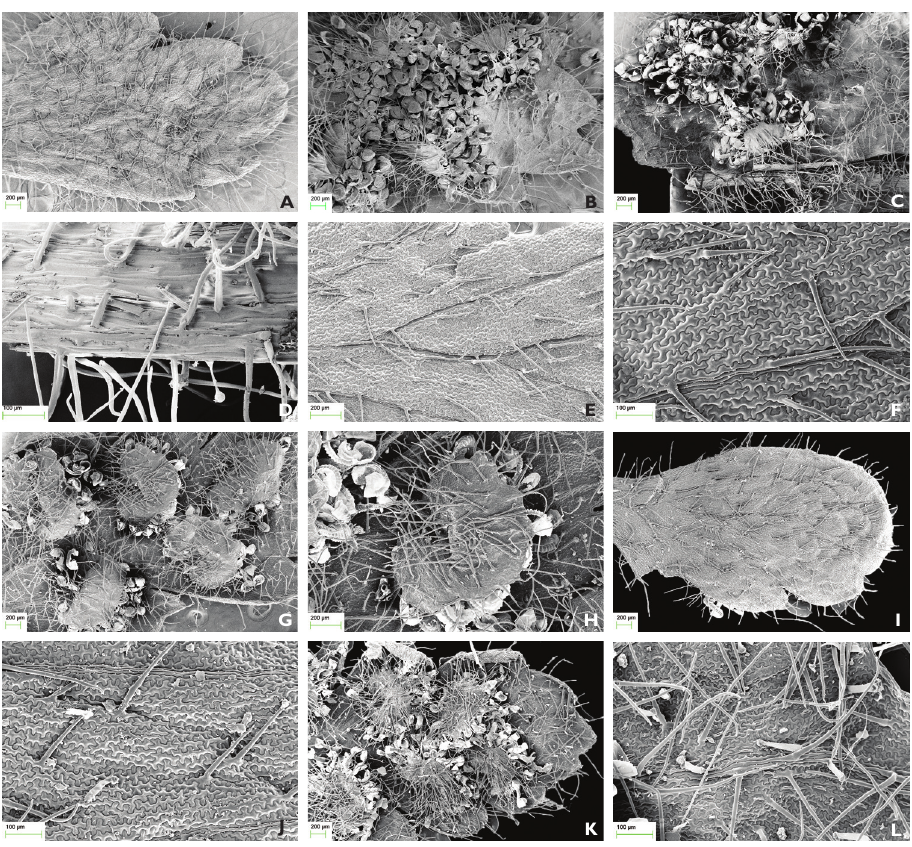
Figure 3. The fronds and rachis of H. confertivillosum , H. crenatum and H. glanduloso-pilosum (SEM). A H. confertivillosum fronds densely covered with long hairs adaxially (30×) B H. confertivillosum fronds and indusia densely covered with long hairs and sparsely rod-shaped glandular hairs abaxially (30×) C H. confertivillosum fronds and costae densely covered with long hairs and sparsely rod-shaped glandular hairs abaxially (30×) D H. confertivillosum costae densely covered with long hairs and sparsely rod-shaped glandular hairs abaxially (160×) E H. crenatum fronds sparsely covered with acicular hairs adaxially (60×) F Close-up view of H. crenatum fronds covered with acicular hairs adaxially (140×) G H. crenatum fronds and indusia densely covered with long hairs abaxially (30×) H Close-up view of H. crenatum indusia covered with long hairs abaxially (60×) I H. glanduloso-pilosum fronds densely covered with acicular hairs and rod-shaped glandular hairs adaxially (30×) J Close-up view of H. glanduloso-pilosum fronds covered with acicular hairs and rod-shaped glandular hairs adaxially (140×) K H. glanduloso-pilosum fronds and indusia densely covered with long hairs and rod-shaped glandular hairs abaxially (30×) L Close-up view of H. glanduloso-pilosum fronds covered with long hairs and rod-shaped glandular hairs abaxially